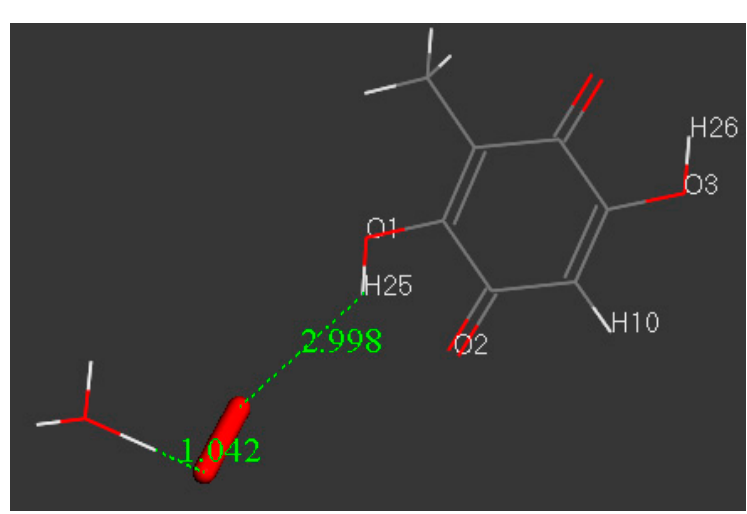
Figure 6. After the system shown in Figure 5 is minimized, a H(hydronium) is captured and a O 2 H